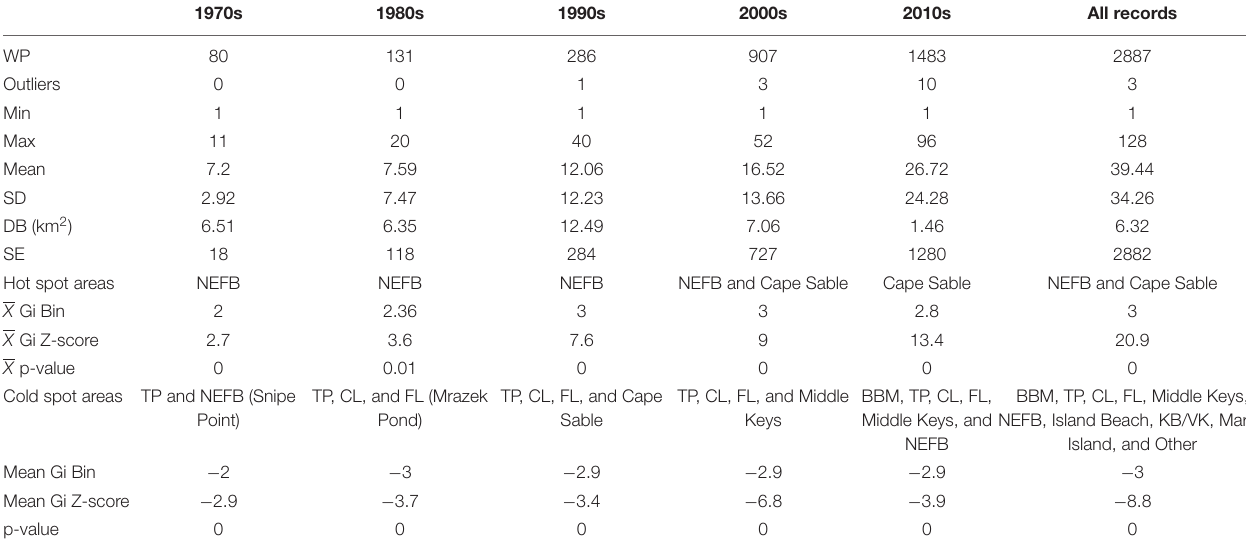
TABLE 3 | Results of the optimized hot spot analysis (OHSA) of American crocodile ( Crocodylus acutus ) nests identified across South Florida from 1970 to 2020.